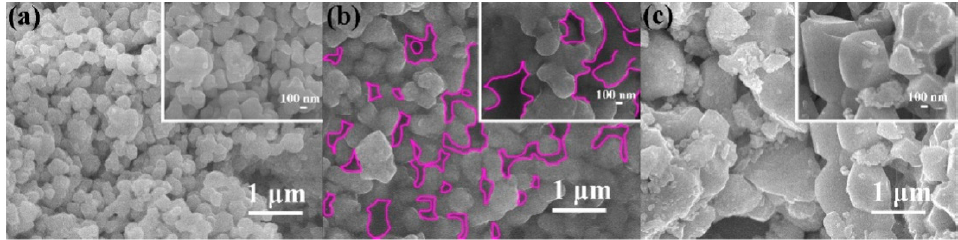
Figure 17. SEM image of La 2 NiFeO 6 (sintered at three different temperatures; ( a ) 1000, ( b ) 1100, and ( c ) 1200 °C) [134]. ( c ) 1200 ◦ C)